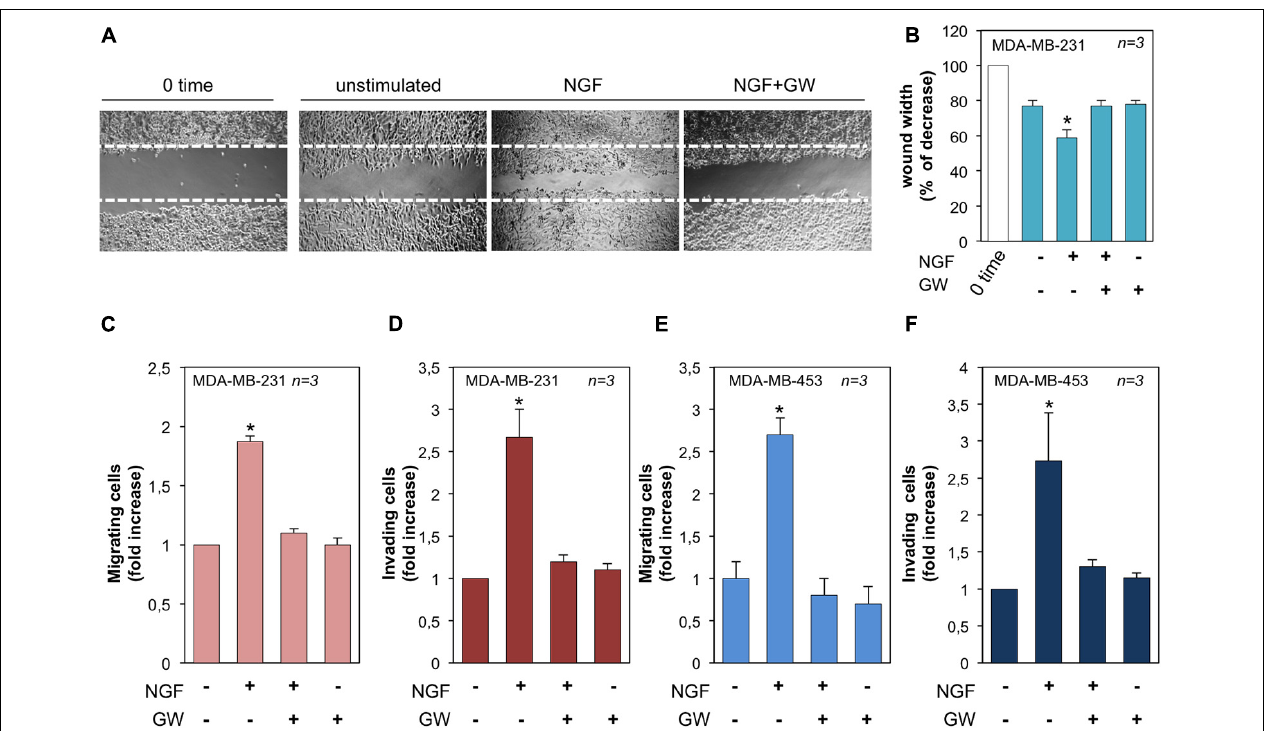
FIGURE 5 | Neurotrophin β -nerve growth factor (NGF) challenge induces migration and invasiveness in triple-negative breast cancer (TNBC) cells. (A) Quiescent MDA-MB-231 cells were wounded and left unstimulated or stimulated with NGF for 18 h in the absence or presence of GW441756 (GW). Phase-contrast images are representative of three different experiments, each in duplicate. (B) Wound area calculated using Leica Suite software. Data are presented as the percentage of decrease in wound width over the control cells, analyzed at time 0. (C–F) Quiescent MDA-MB-231 (C) and MDA-MB-453 (E) cells were used for migration assays in Boyden chambers pre-coated with collagen. Quiescent MDA-MB-231 (D) and MDA-MB-453 (F) cells were used for invasion assays in Boyden chambers pre-coated with Matrigel. The indicated compounds were added to the upper and the lower chambers and the cells were counted as reported in “Materials and Methods.” Results from three different experiments were collected and expressed as fold increase. In (B–F) , means and SEMs are shown. n represents the number of experiments. * p < 0.05 for the indicated experimental points vs . the corresponding untreated